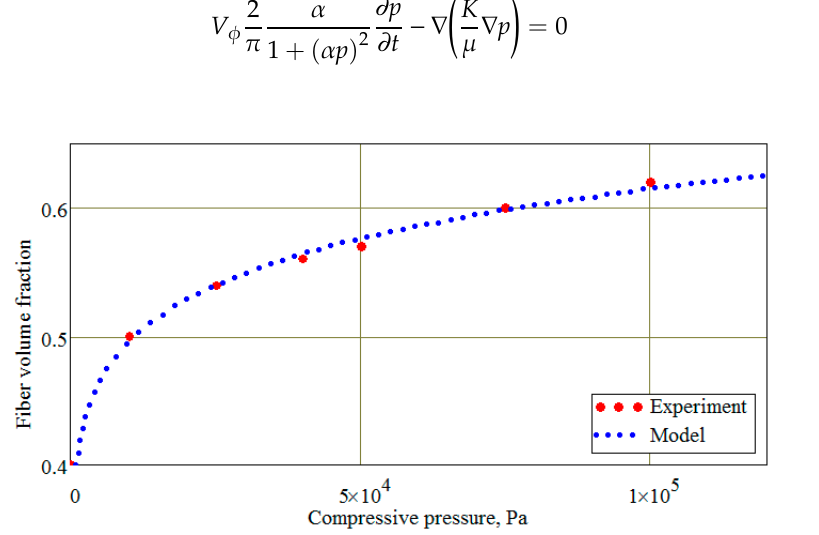
Figure 9. The dependence of the reinforcement volume fraction V f on the compacting pressure: experimental data borrowed from the article [6] and their approximation by the model in Equation (10) with the parameters: V f 0 = 0.21; B = 0.093.